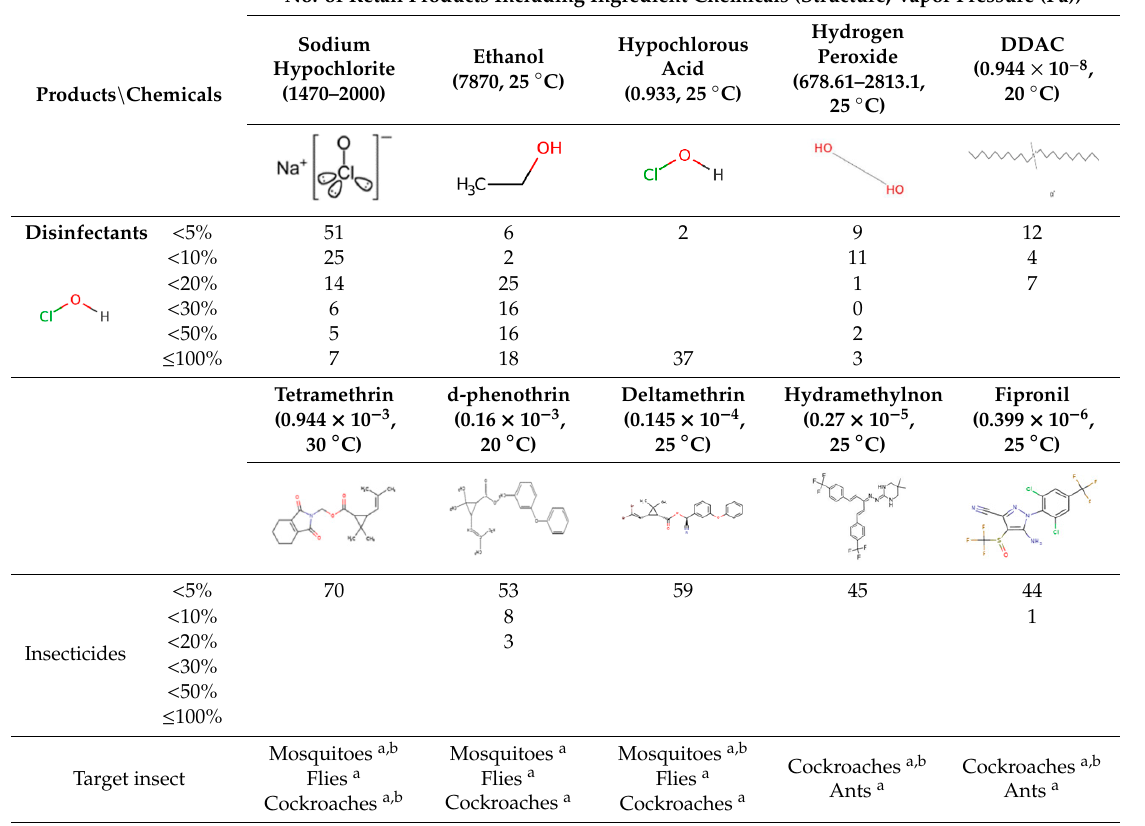
Table 6. Mixing ratio of major chemicals used in products as ingredients.